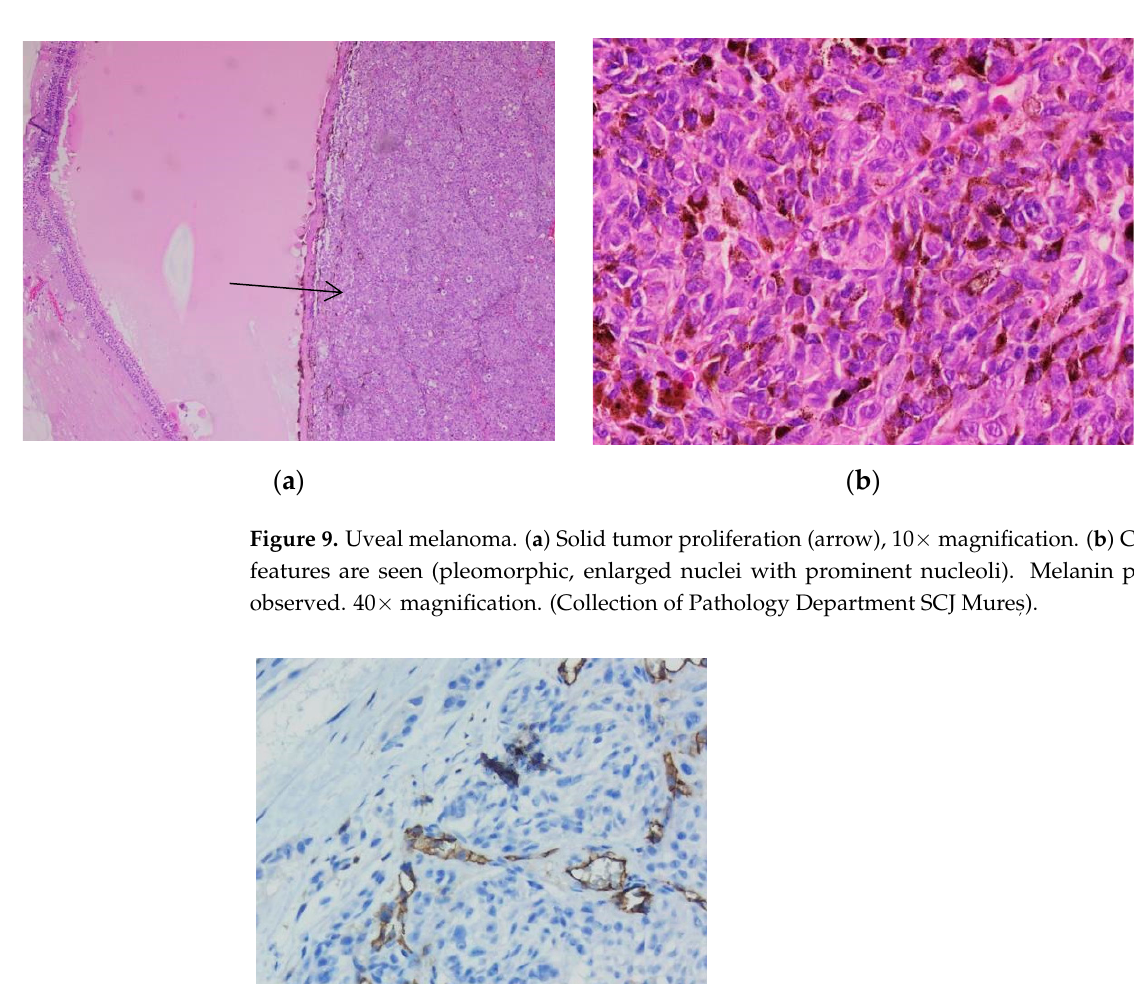
Figure 10. Uveal melanoma. Quantification of microvascularisation using CD31 immunostaining. 20× magnification. (Collection of Pathology Department SCJ Mure ș ).